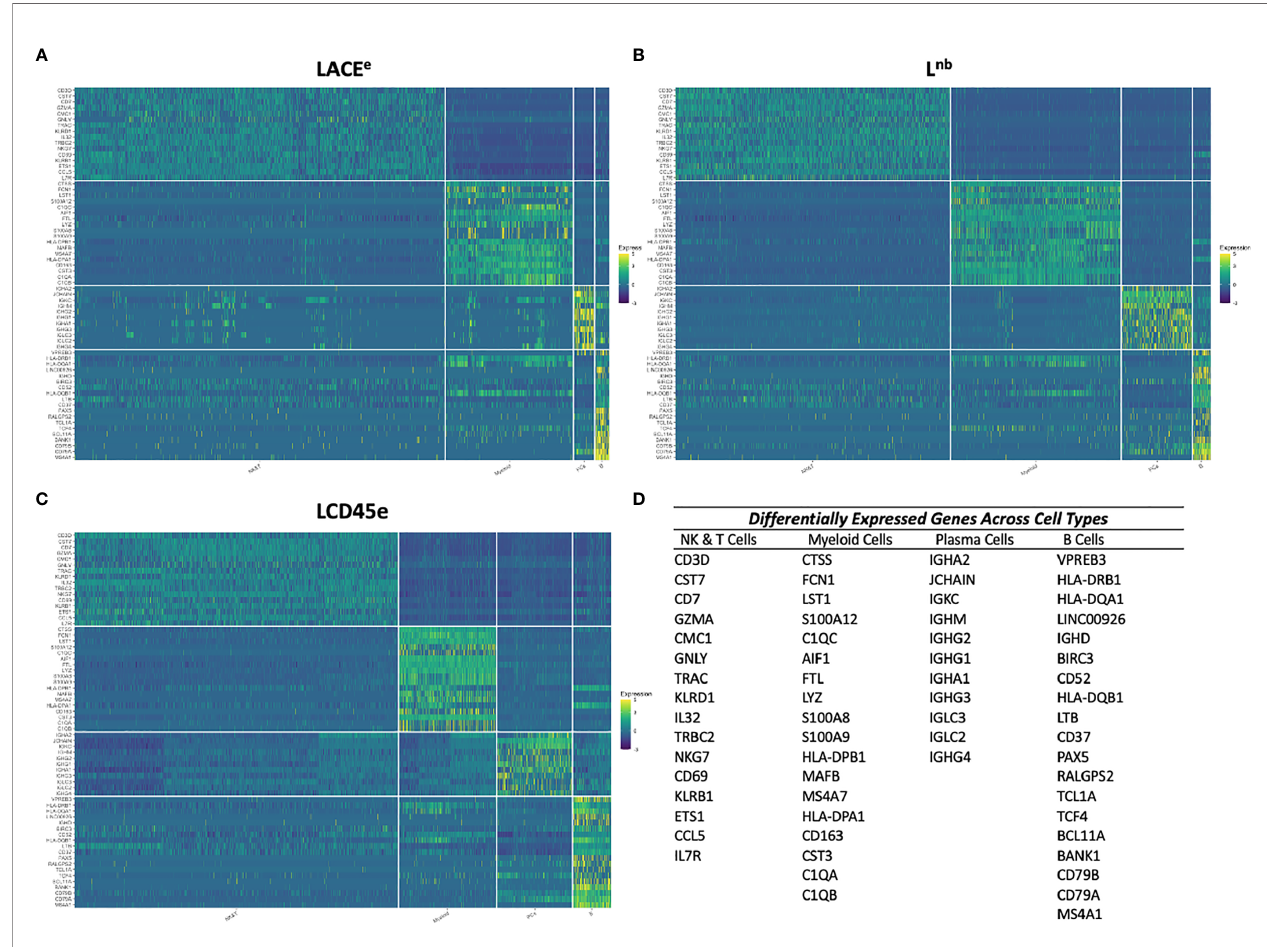
FIGURE 4 | Heatmap representation of dominant differentially expressed genes between each immune cell subpopulation in each dataset. (A) Heatmap of the most DE genes across leukocyte subpopulation plotted using cells from the LACE e dataset. (B) Heatmap of the most DE genes across immune cell subpopulation plotted using cells from the L nb dataset. (C) Heatmap of the most DE genes across leukocyte subpopulation plotted using cells from the LCD45 e dataset. For all heatmaps, z-scores are shown representing standardized, log normalized expression across cells for a given gene. (D) Table of the list of genes used for heatmap analysis for each leukocyte subpopulation. Immune cell subpopulations are grouped from left to right: NK&T, myeloid cells, plasma cells then B cells and the gene lists going from top to bottom are ranked in the same order. The same gene lists were used to analyze cells from each of the three